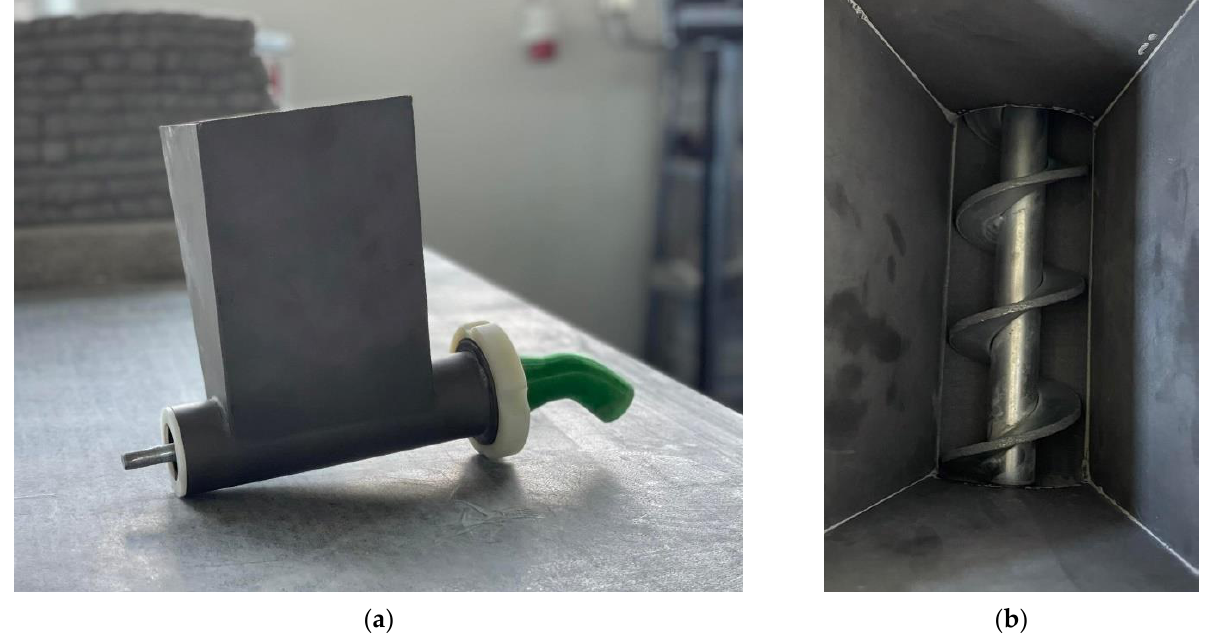
Figure 6. Extrusion equipment for fresh silicate mixtures ( a ) side view ( b ) top